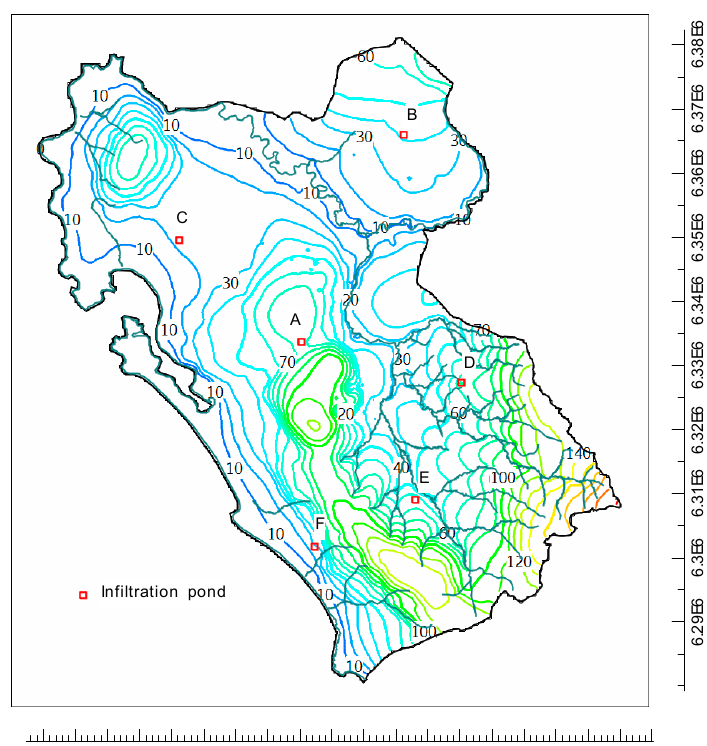
Figure 11. Simulated groundwater level map of the study area. The unit of the horizontal and vertical scale is in meters (m).